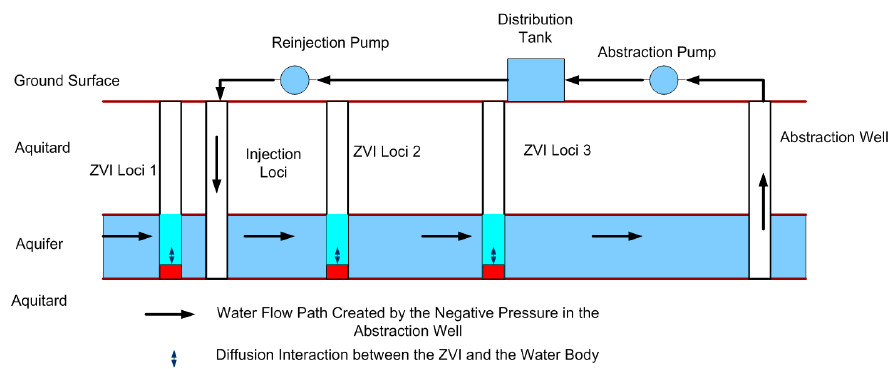
Figure 20. Process flow diagram for a schematic aquifer, which has been reconfigured as an Aquifer Treatment Zone with recycle ( Recycle Strategy ). S = salinity.